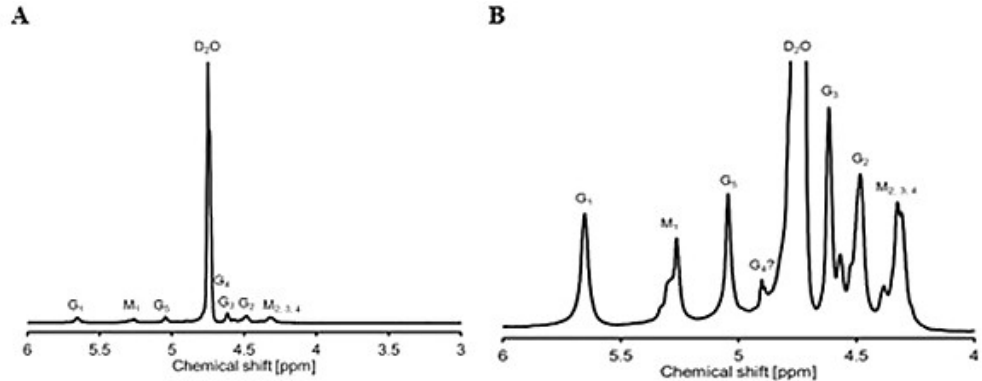
Figure 1. ( A ) Spectra of 1 H NMR spectra of alginate from S. Ilicifolium (90 °C 128 scans); ( B ) detail of 1 H NMR spectra (90 °C 128 sc).